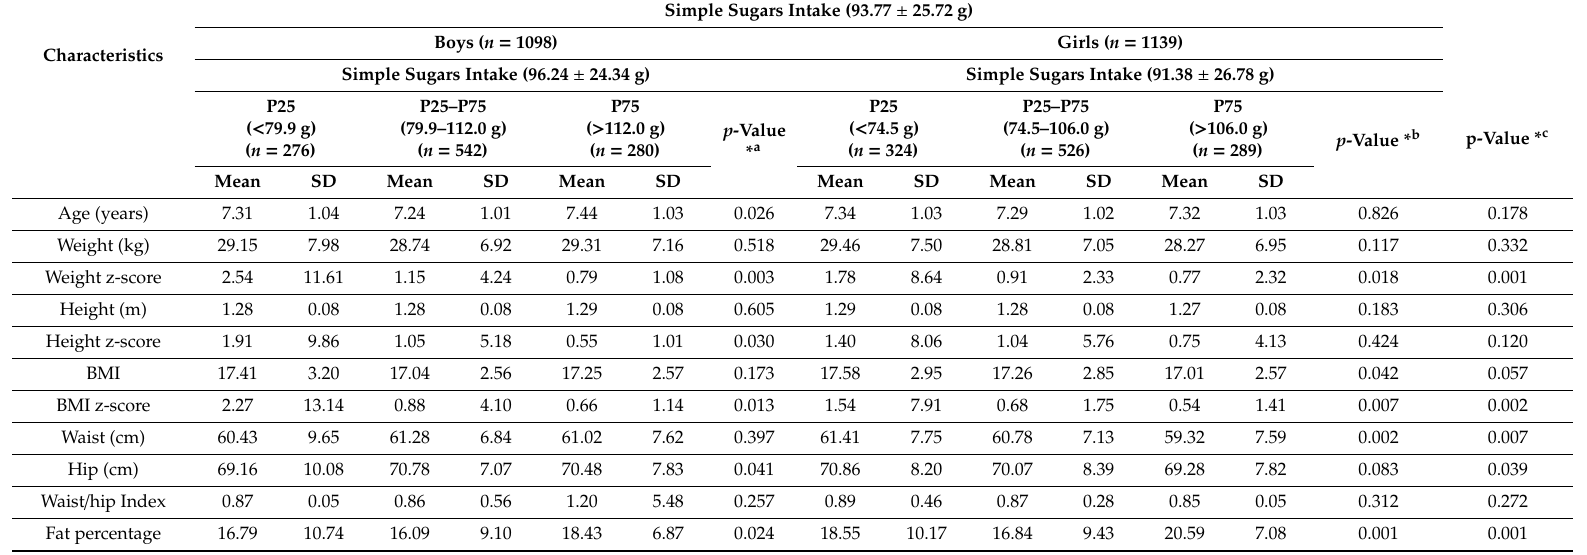
Table 5. Anthropometric characteristics of schoolchildren in relation to sugar intake consumed by 6–8 years old children ( n = 2237) in Valencia, Spain, 2018.